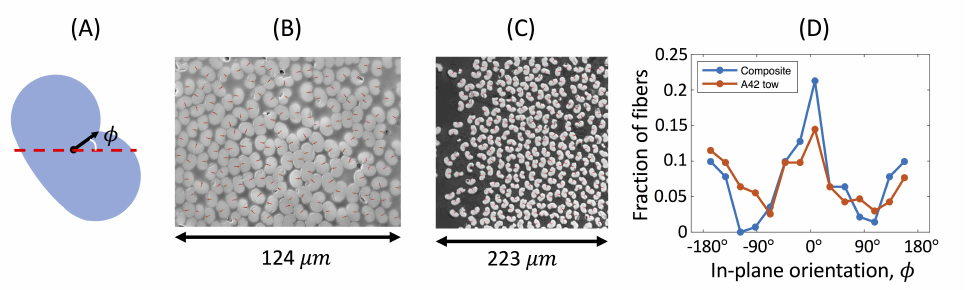
Figure 1. Shown in ( A ) is a schematic of an A42 carbon fiber with a definition of the in-plane angle, φ , ( B ) shows an SEM image of an A42/P6300 composite specimen (sectioned and polished), with vectors overlaid for the in-plane orientations, ( C ) shows an optical microscopy image of the A42 fiber tow prior to resin infusion also with vectors overlaid for the in-plane orientations, and ( D ) shows the computed in-plane orientation